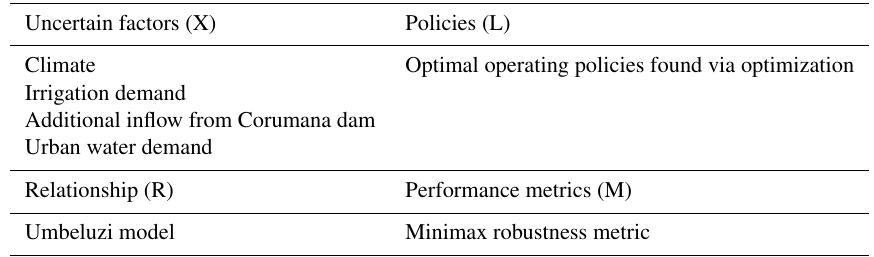
Table 2. Conceptualization of the robustness analysis implemented in this